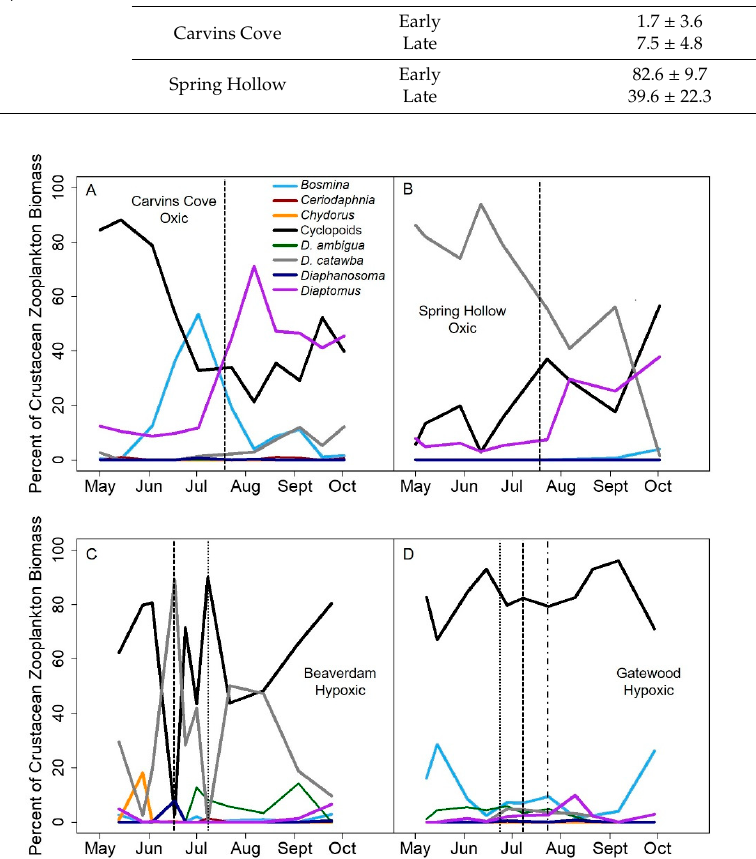
Figure 4. The percent of each crustacean zooplankton taxon observed in ( A ) Carvins Cove, ( B ) Spring Hollow, ( C ) Beaverdam and ( D ) Gatewood within each sampling date during the sampling season in 2014. The vertical lines denote the early and late stratified period in analyses for oxic (20 July) and hypoxic (dash: 2014; dash-dot: 2015; dotted: 2016) reservoirs.